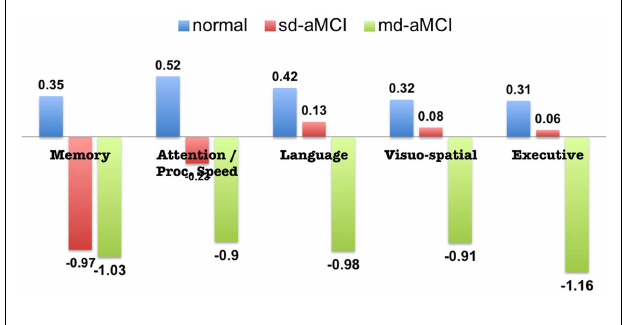
FIGURE 1 | Neuropsychological assessment of aMCI and normal subjects included in this study (standardized scores, mean)